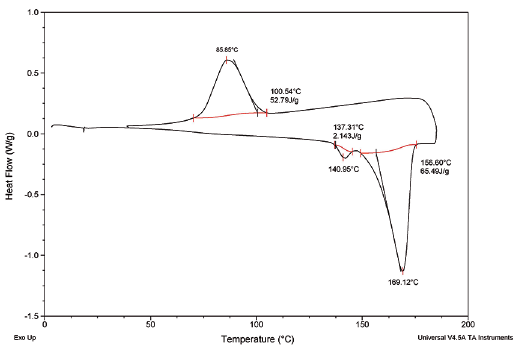
Figure 2: DSC curve of PHB before processing